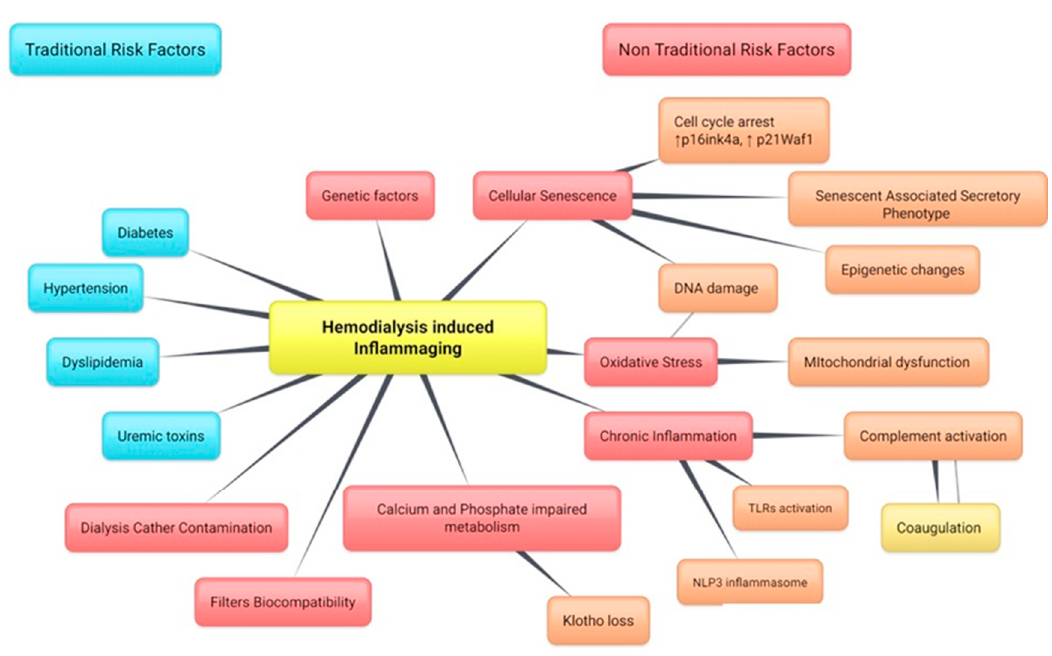
Figure 1. Factors involved in hemodialysis-induced inflammaging divided into traditional risk factors (in blue) and non-traditional risk factors (in red). Inflammaging is defined as the systemic, low-grade inflammation associated with increased pro-inflammatory cytokines in blood and tissues and represents a frequent cause of disability in elderly subjects. Inflammaging can be induced by a wide range of conditions such as diabetes, uremic toxins, genetic factors, or dialyzer biocompatibility. However, from the other side, inflammaging also contributes to the development and amplification of oxidative stress, cellular senescence, and persistent immune activation (i.e., complement system). The dialysis catheter contamination and the filters’ biocompatibility are exogenous risk factors that are dependent on the type of material used and the sterilization methods. On the contrary, genetic susceptibility, chronic inflammation, and the establishment of cellular senescence are examples of endogenous, patient-dependent risk factors. NRLP3, NOD-like receptor P3.